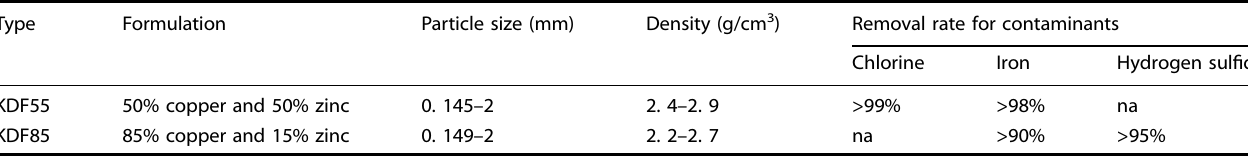
Table 7. Comparison of KDF55 and KDF85 71,75 .